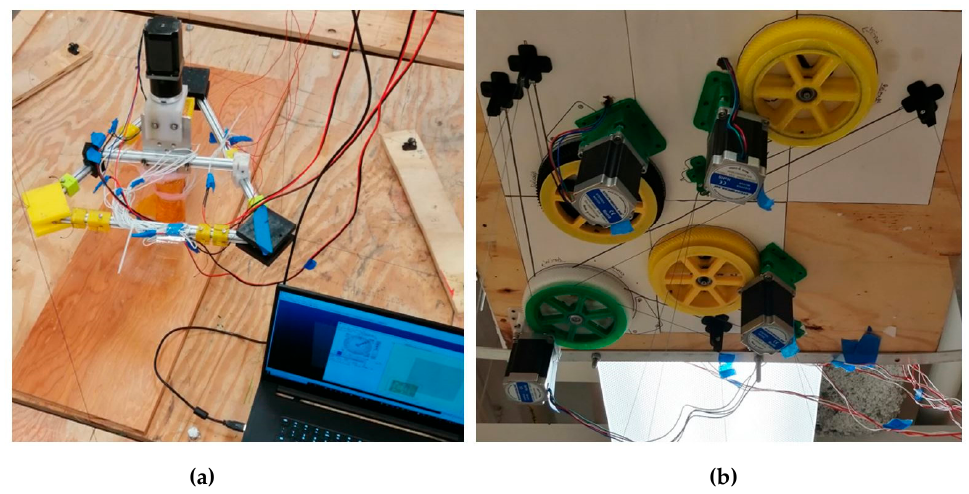
Figure 3. Hybrid printer assembly. ( a ) end effector (FPF/FGF extruder) and the printing bed with A, B, and C anchors, ( b ) ceiling unit with gears, motors, and line rollers.